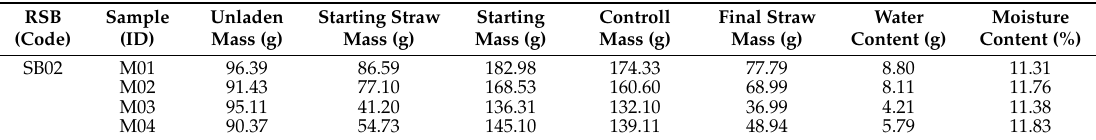
Table 9. Specimen straw moisture.